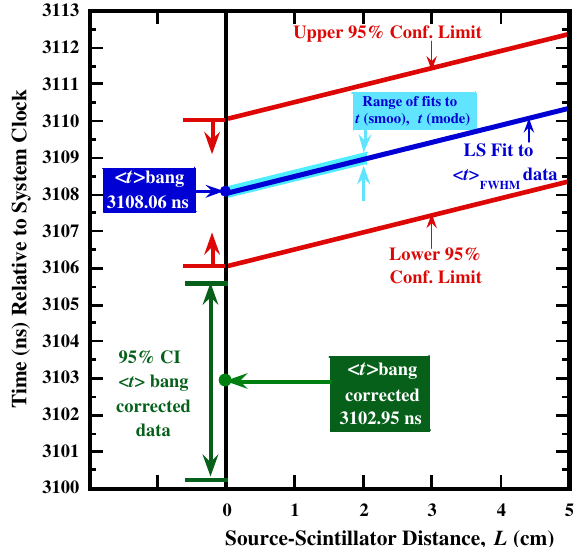
FIG. 8. Extrapolated region of arrival time-vs-distance fit curves for shot 2584. The dark blue fit line results from h t i data with FWHM 95% confidence uncertainty lines (red); extrapolated fits for the t and t data are indicated by the light blue line, truncated Smoo mode for clarity at 2 ns. The green lines below indicate the result for bang time and its uncertainty from h t i data after IRF corrections FWHM have been applied. The regression curve and its uncertainty band are not shown but are closely parallel to the raw data curves above. ( ∼ 3 – 5 ns, Fig. 2) of the IRF throughputs Δ t k have? Corrected parameters for the h t i k data are shown on FWHM the bottom line, labeled h t i in Table III for comparison to corr the top line, labeled h t i . Here, the raw mean arrival times